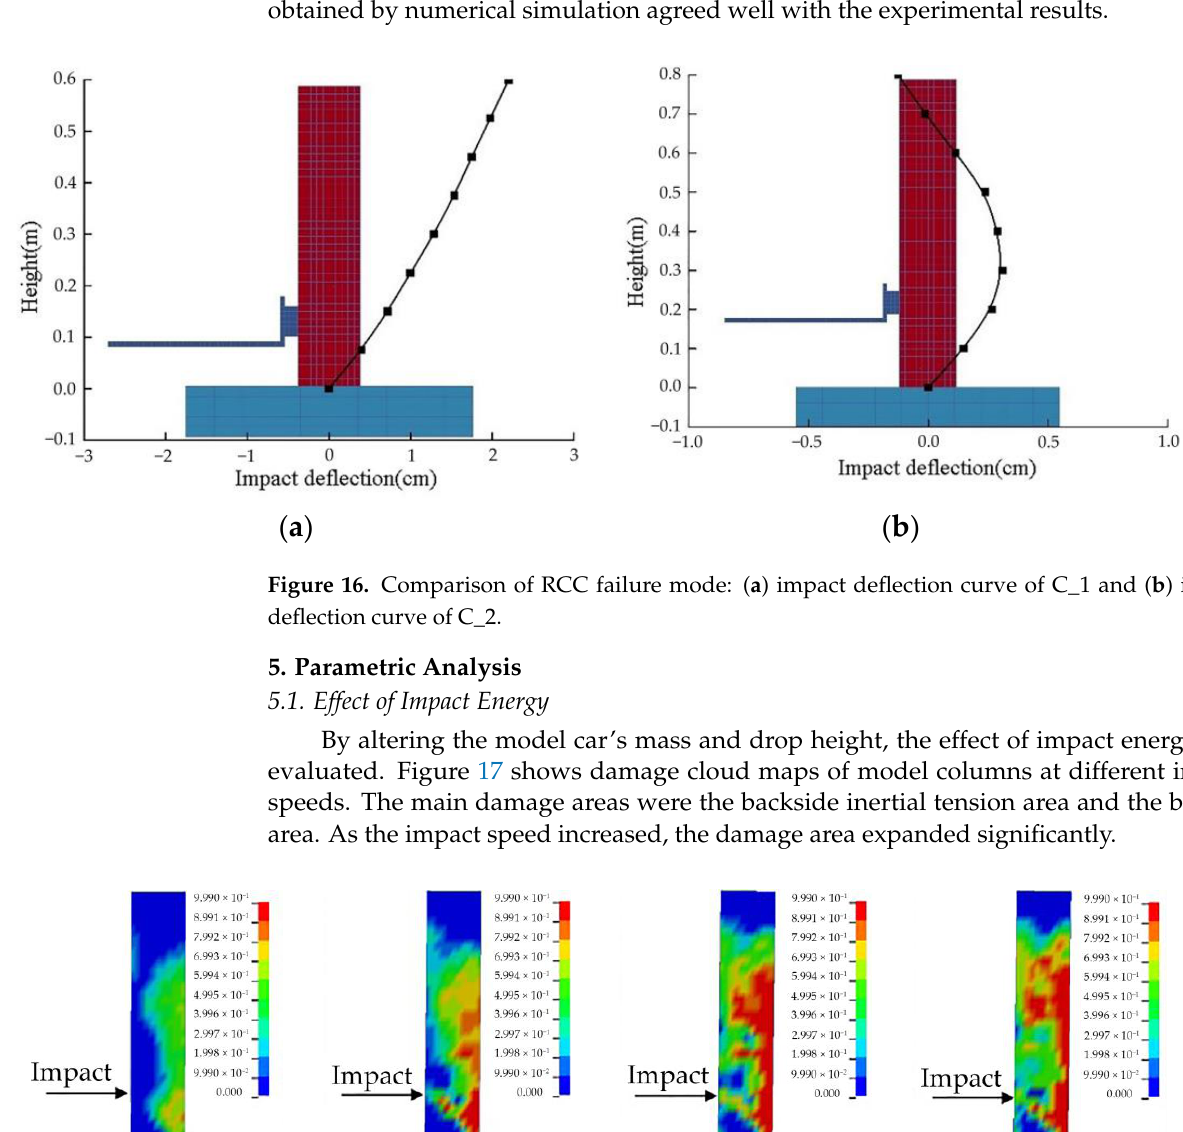
Figure 17. Comparison of damage at different impact speeds: ( a ) v = 2.425 m/s; ( b ) v = 3.960 m/s; ( c ) v = 5.422 m/s; ( d ) v = 6.260 m/s. Impact body mass and impact velocity are the two most important factors affecting the contact interface force [27]. Equivalent static impact loads are expressed mostly as a the function of impact mass and impact velocity [1]. Figure 18 shows the relationships among peak contact interface force, impact velocity, and impact mass.